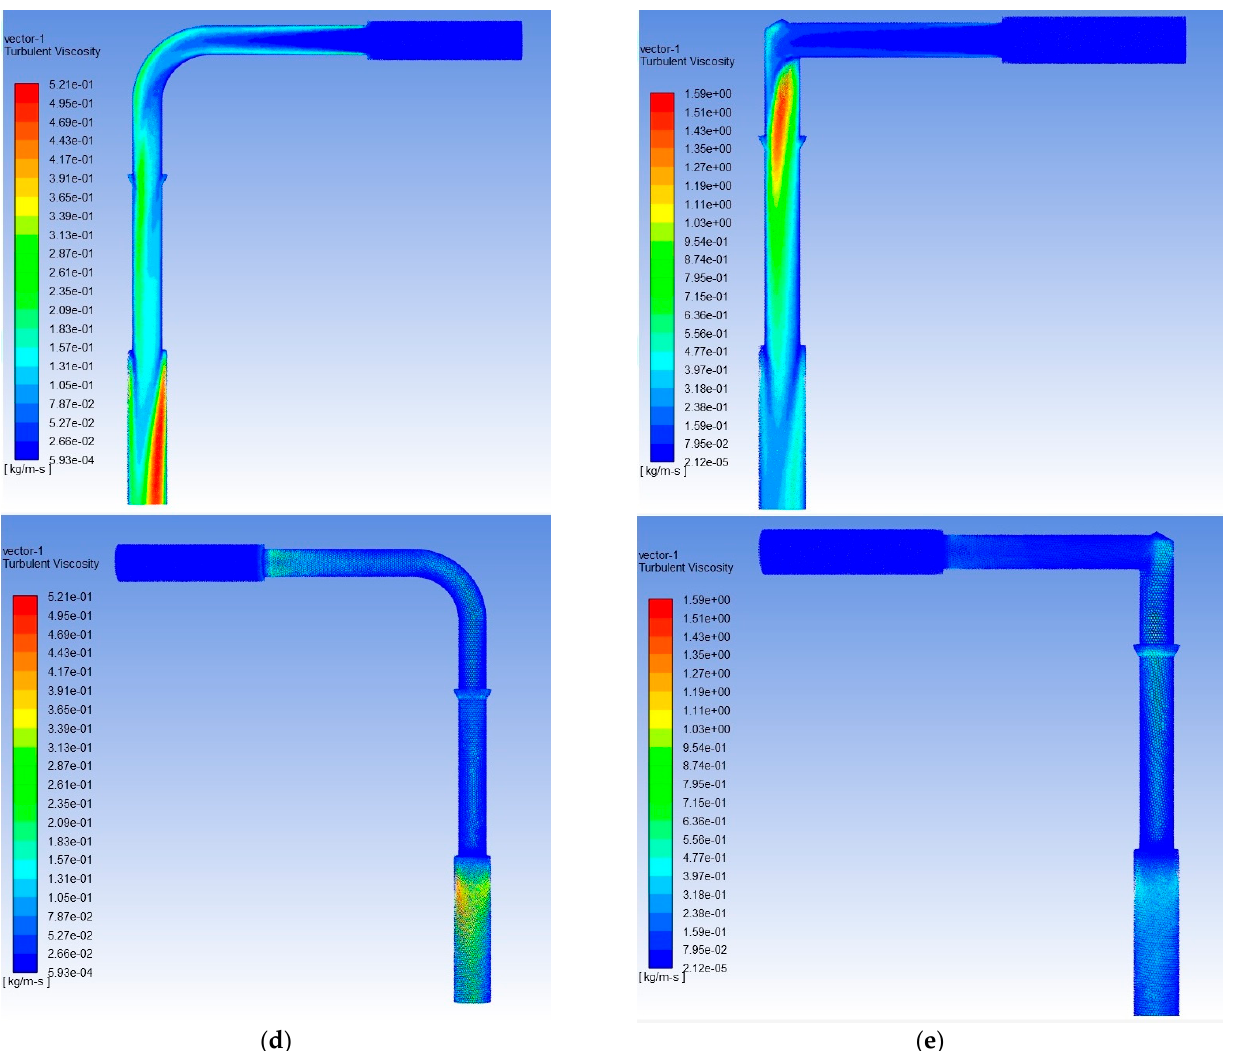
Figure 8. View of the fluid flow turbulence processes across angular fitting connections (top—symmetry side; bottom—wall side): ( a ) equivalent length method; ( b ) DKR 45° connection; ( c ) DKR 45°K connection; ( d ) DKR 90° connection; ( e ) DKR 90°K connection.